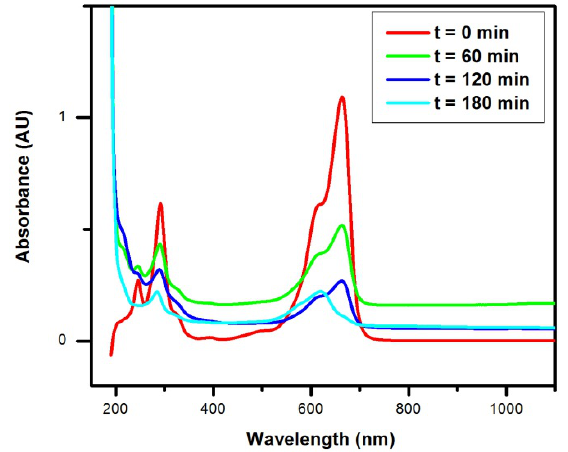
Fig. 11. Optical absorbance spectra of MB dye using